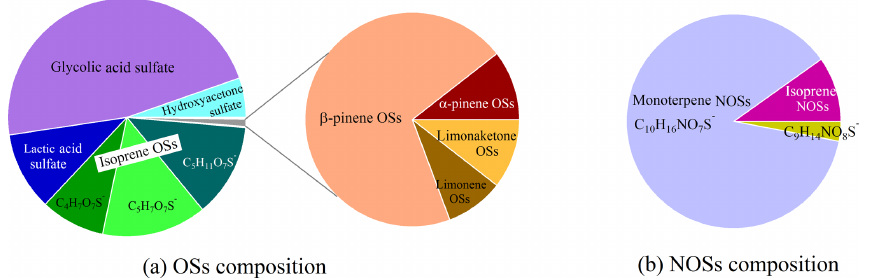
Figure 2. The relative contribution of different (a) OS and (b) NOS species. Only the selected species (semi-)quantified by HPLC–MS are included in this